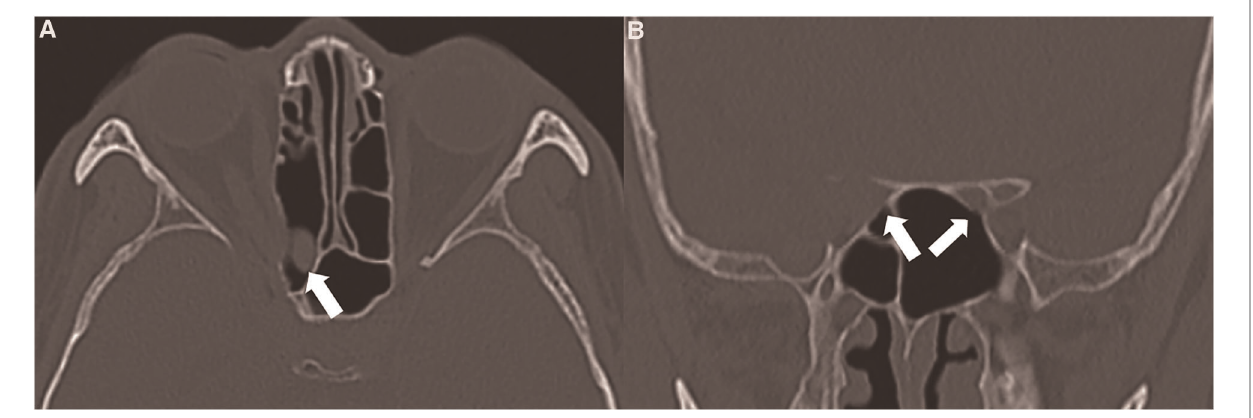
FIGURE 2 | ( A ) the suspected tumour originated in the sphenoid sinus or invaded the sphenoid sinus from the cranio-orbital area (thick white arrow). ( B ) The tumour destroyed the right optic canal and involved the right optic nerve, and the side wall of the sphenoid sinus remained intact (thin white arrow). The left optic canal was intact (thin